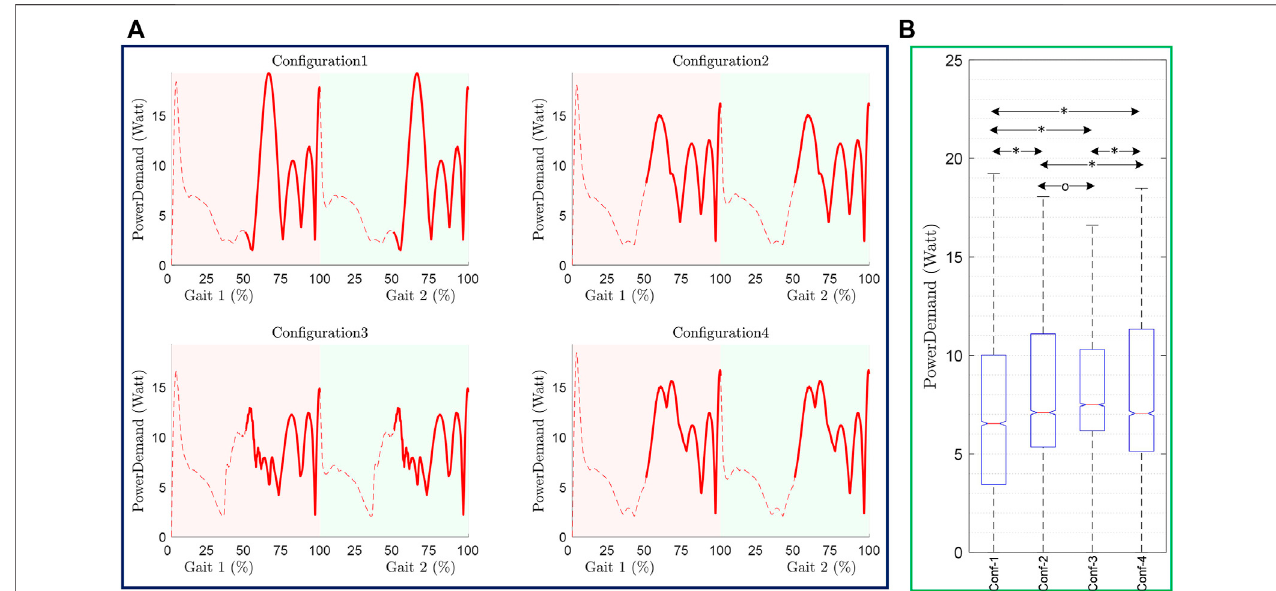
FIGURE 10 | Power demand in C-LREX throughout Gait cycle (A) and one-way ANOVA analysis (B) . The pairwise signi fi cant difference and no signi fi cance between the con fi gurations are marked as ‘ * ’ , and ‘ o ’ respectively. p- value less than 0.05 is taken as a signi fi cant difference.